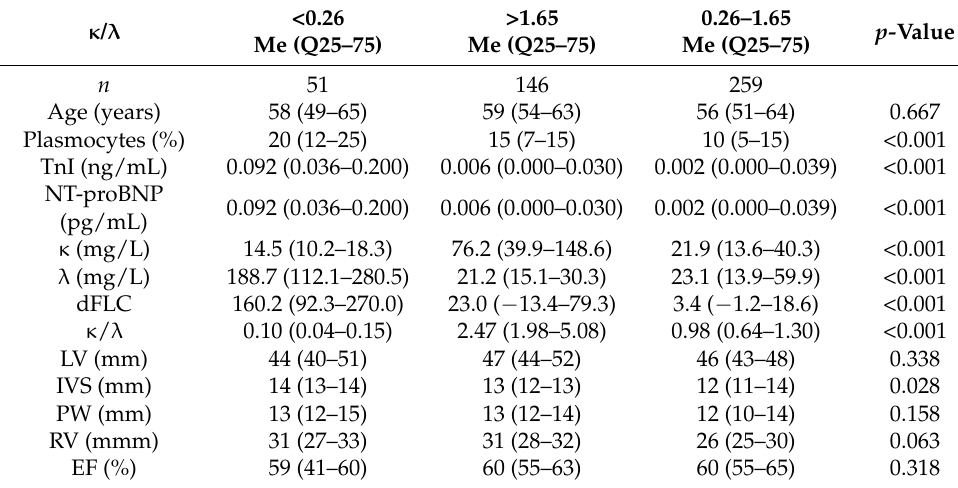
Table 4. Comparative analysis of study groups divided based on free chain concentration ratio κ / λ : <0.26, >1.65, and 0.26–1.65.